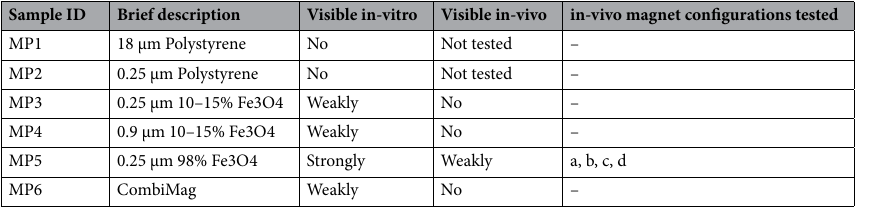
Table 2. Visibility of the tested magnetic particles using PCXI at SPring-8